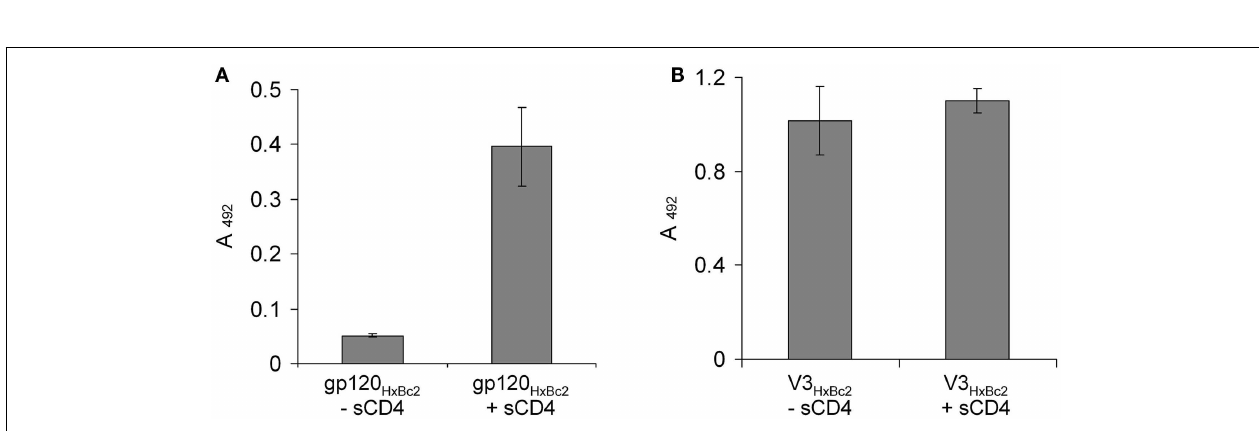
FIGURE 3 | Binding of gp120 (in the presence of sCD4) (A) andV3 loop peptides (B) from X4 tropic (IIIB, HxBc2, and MN) and R5-tropic (BAL andADA) HIV-1 to the CXCR4 mimetic peptide CX4-M1 . See Section “Materials and Methods” (direct ELISA) for experimental detail. Error bars present deviations from the mean.